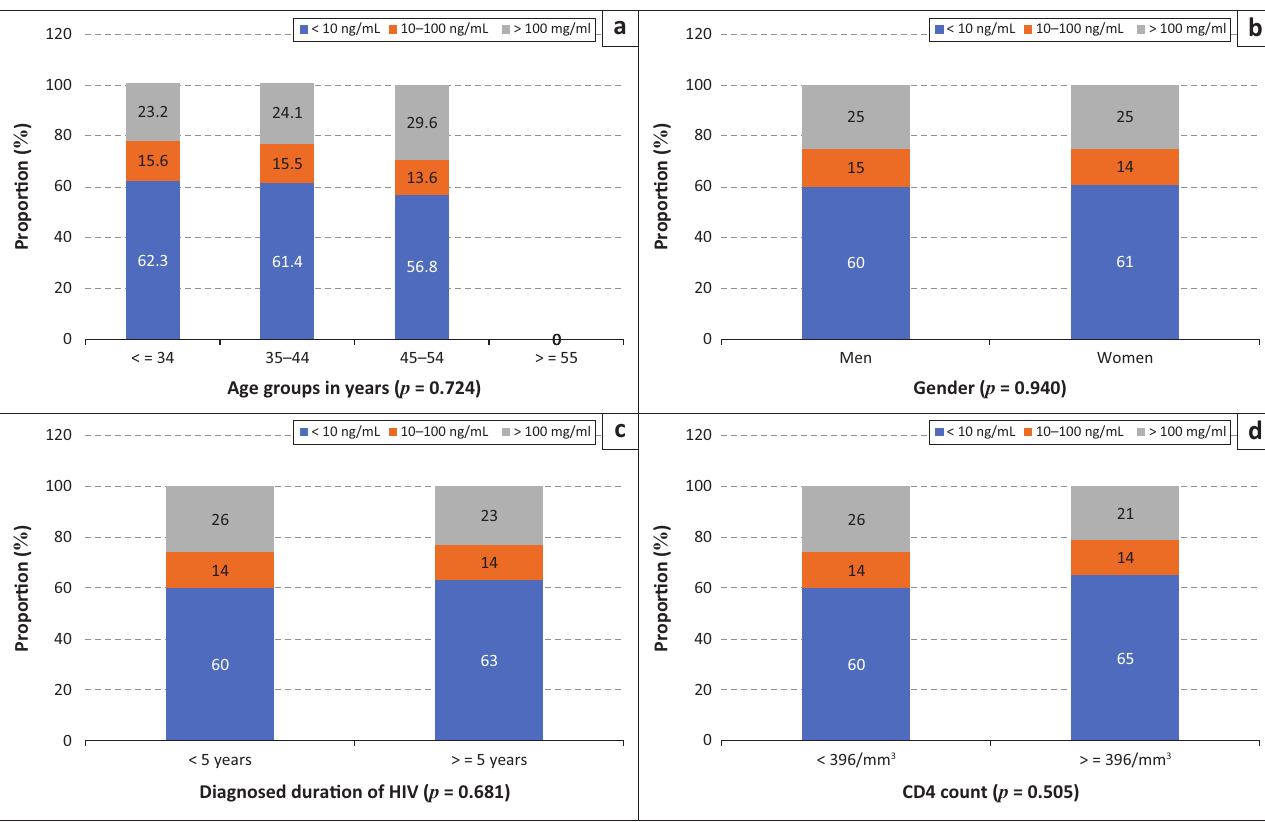
CD4, cluster of differentiation 4; HIV, human immunodeficiency virus. FIGURE 2: Distribution of cotinine strata by (a) age group, (b) gender, (c) known duration of human immunodeficiency virus infection and (d) cluster of differentiation 4